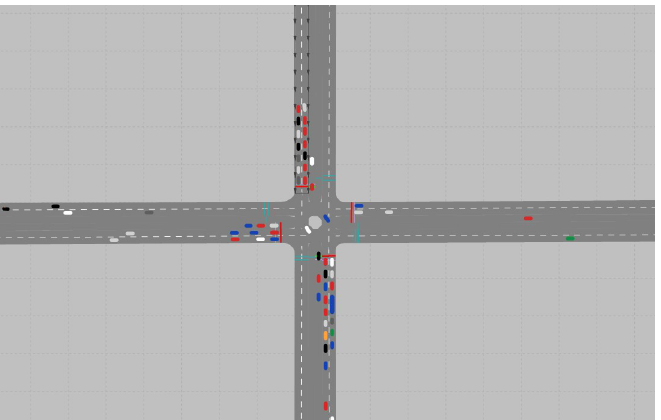
Fig 5. Simulation network of isolated